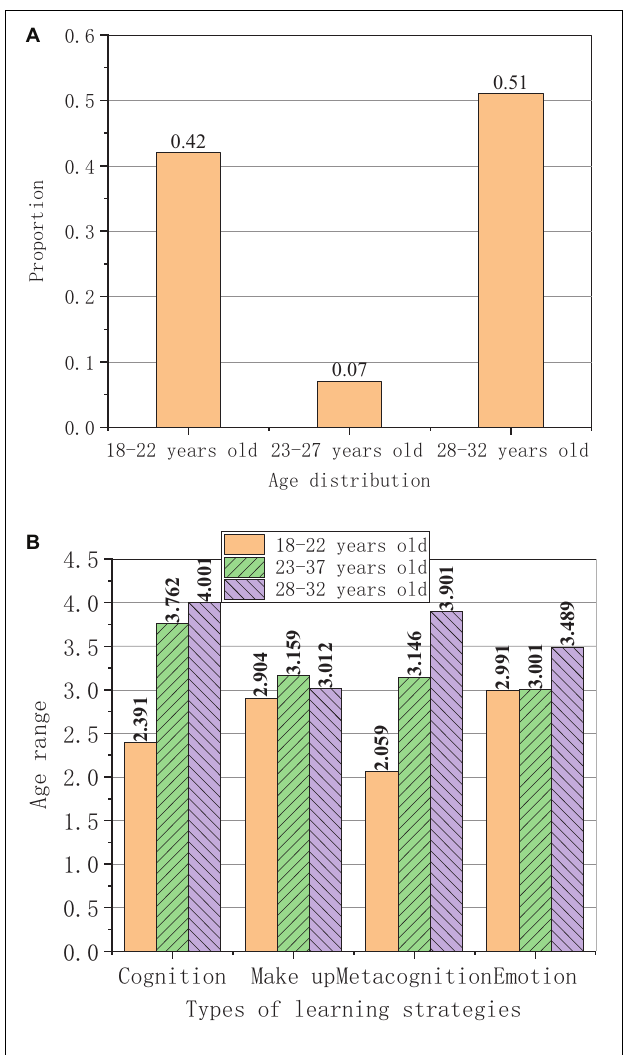
FIGURE 11 | Survey results of the relations between learning strategies used by foreign students and their ages. (A) Ages. (B) Use of different Chinese learning strategies.